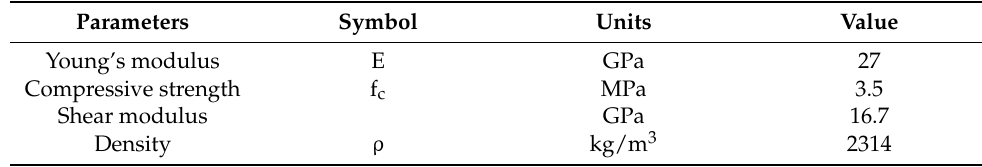
Figure 2. Field test M&S model. Table 4. Material properties of concrete slab for the model.